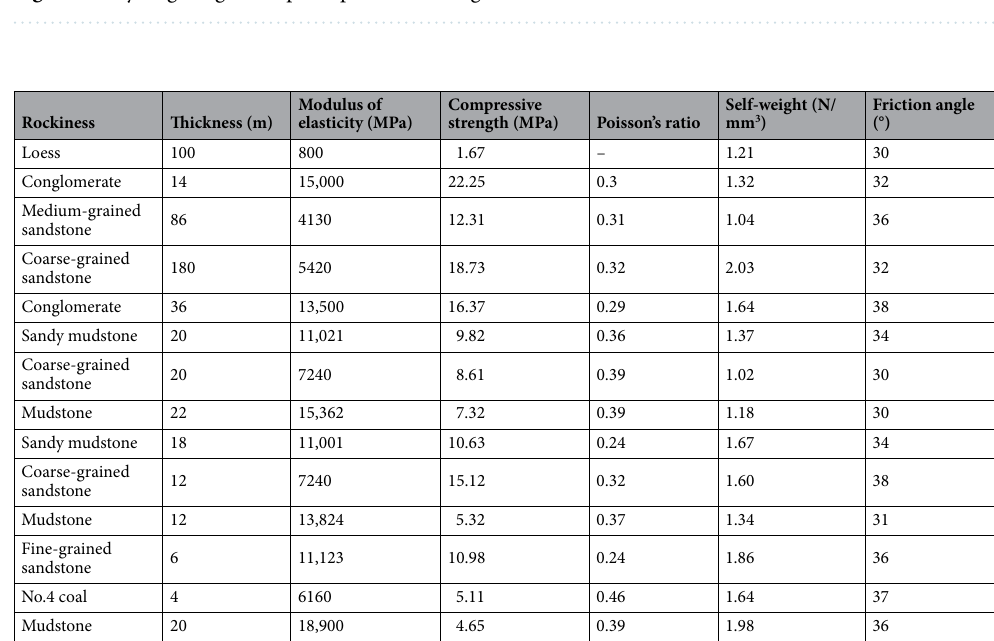
Figure 2. Hydrogeological slope map of monitoring area.